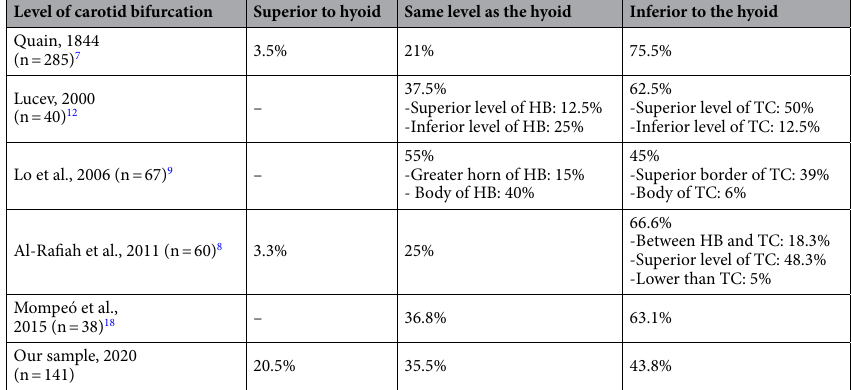
Table 2. Level of carotid bifurcation studied in cadaveric samples. N sample size of carotid specimens, HB hyoid bone, TC thyroid